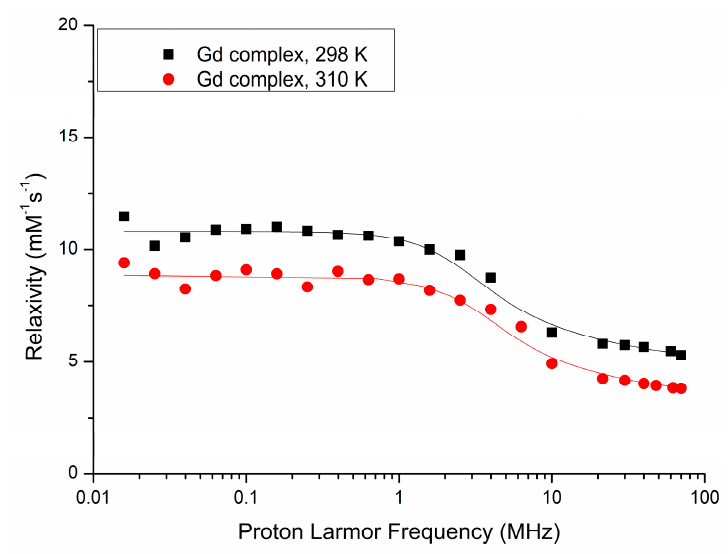
Figure 5. Nuclear magnetic relaxation dispersion (NMRD) profile of Gd-DOTAMA-thiol (compound 3 ) at 298 K and 310 K. Table 1. NMRD best fit parameters derived from NMRD profile of Gd-DOTAMA-thiol (compound 3 ) at 298 K and 310 K (Figure 5).